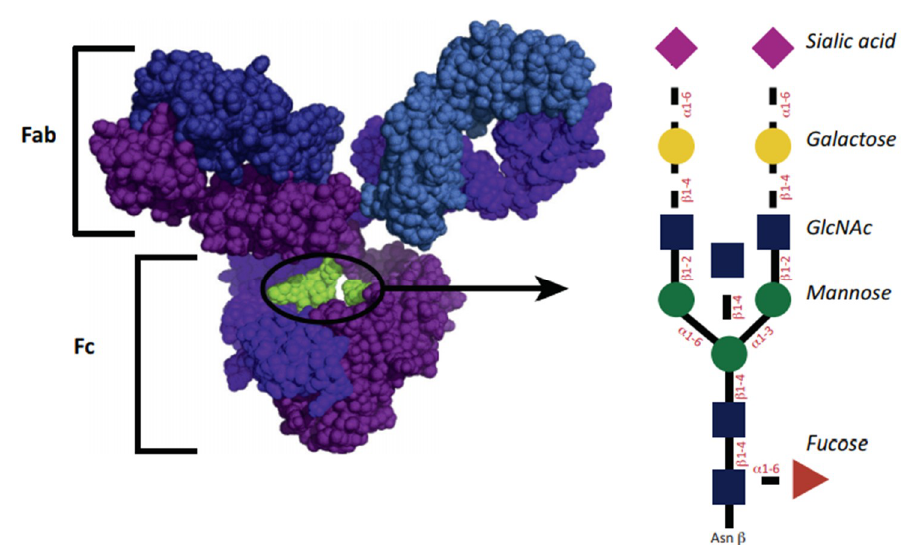
Figure 1. Antibody and glycan structure. Reprinted from [27], reprinted with the permission of